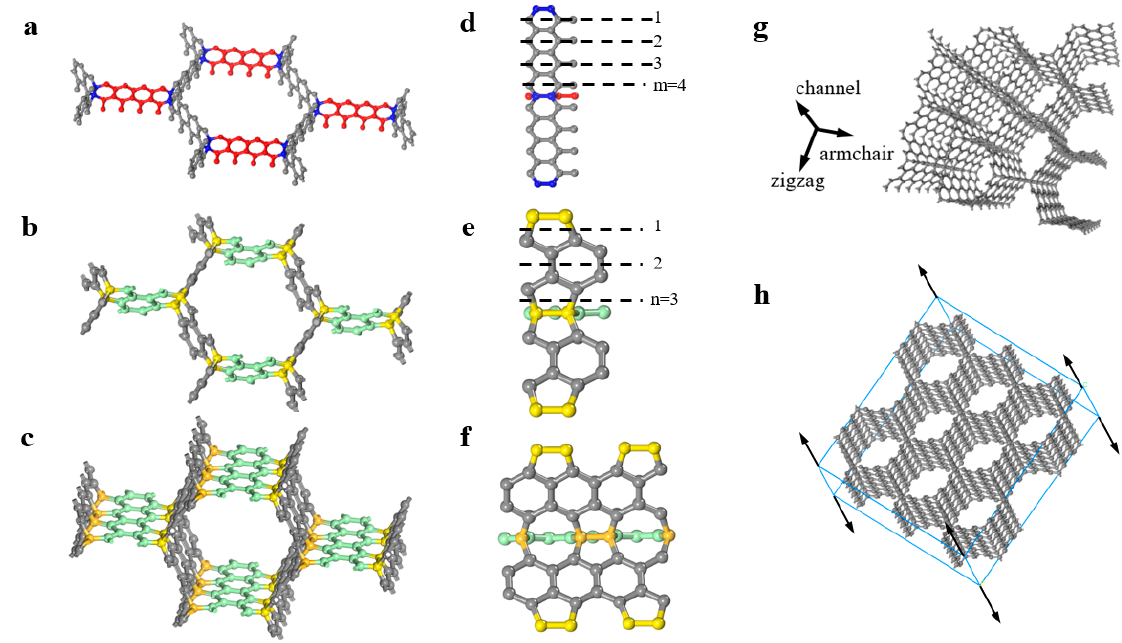
Figure 1. Honeycomb structures in ( a ) zigzag sp 2 –sp 3 -bonded carbon honeycomb (zz 4 –sp 2 –sp 3 CHC), ( b ) symmetrical armchair sp 2 –sp 3 -bonded carbon honeycomb (sym-ac 3 –sp 2 –sp 3 CHC), and ( c )